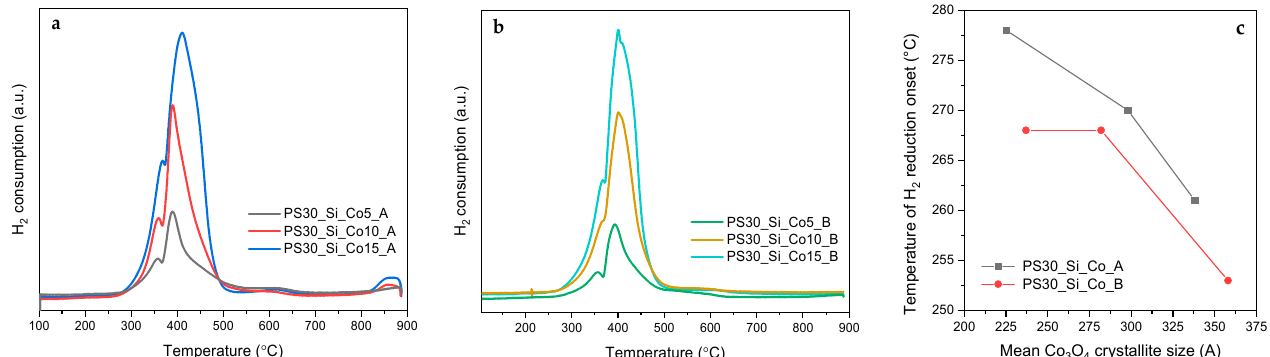
Figure 8. Temperature-programmed reduction profiles of PS30_Si-based catalysts synthesized in the path A ( a ) and B ( b ) as well as relationship between temperature of reduction onset and mean Co 3 O 4 crystallite size ( c ).